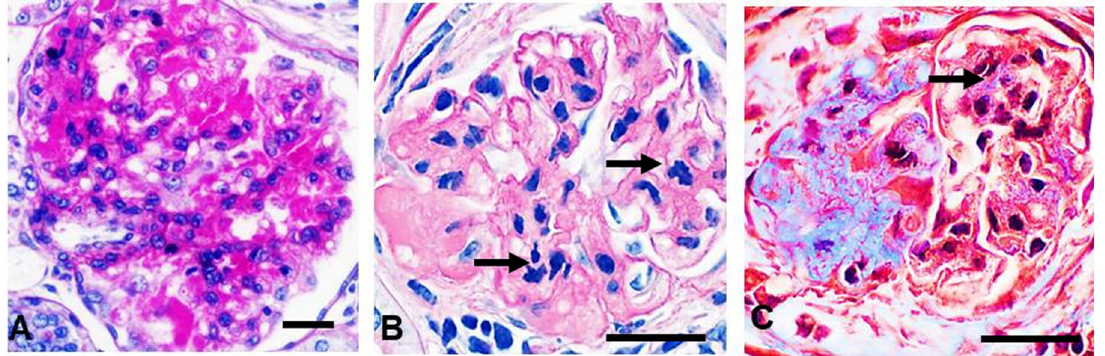
Fig 6. Detailed histopathological features in hypertensive animals. A Only few solidified glomeruli with hyalinosis were found through all scanned sections in the non-clipped kidneys. B, C Classical human-like focal segmental glomerulosclerosis in solidified glomeruli was more frequently detected in renin overexpressing mice with streptozotocin-induced diabetes [92]. Total karyorrhexis (arrows) and mature collagen in globally sclerotic glomeruli was easily found reflecting irreversible glomerular damage. A, B— periodic acid-Schiff; C —Masson trichrome staining. x600.